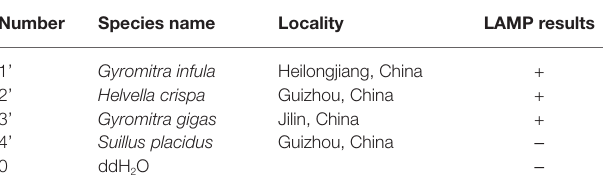
TABLE 4 | The test results of the LAMP primers set II.